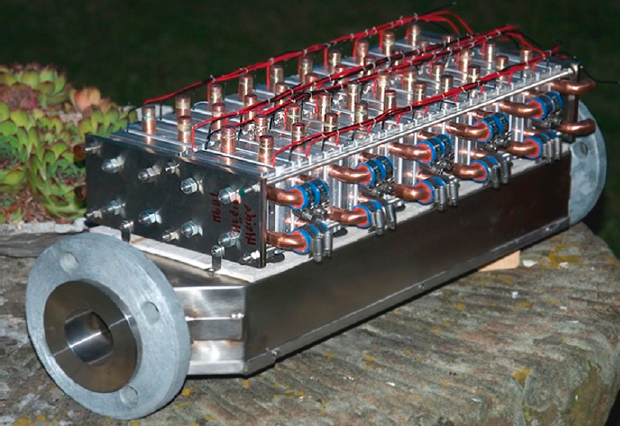
Figure 2. Photo of the TEG heat exchanger hardware.